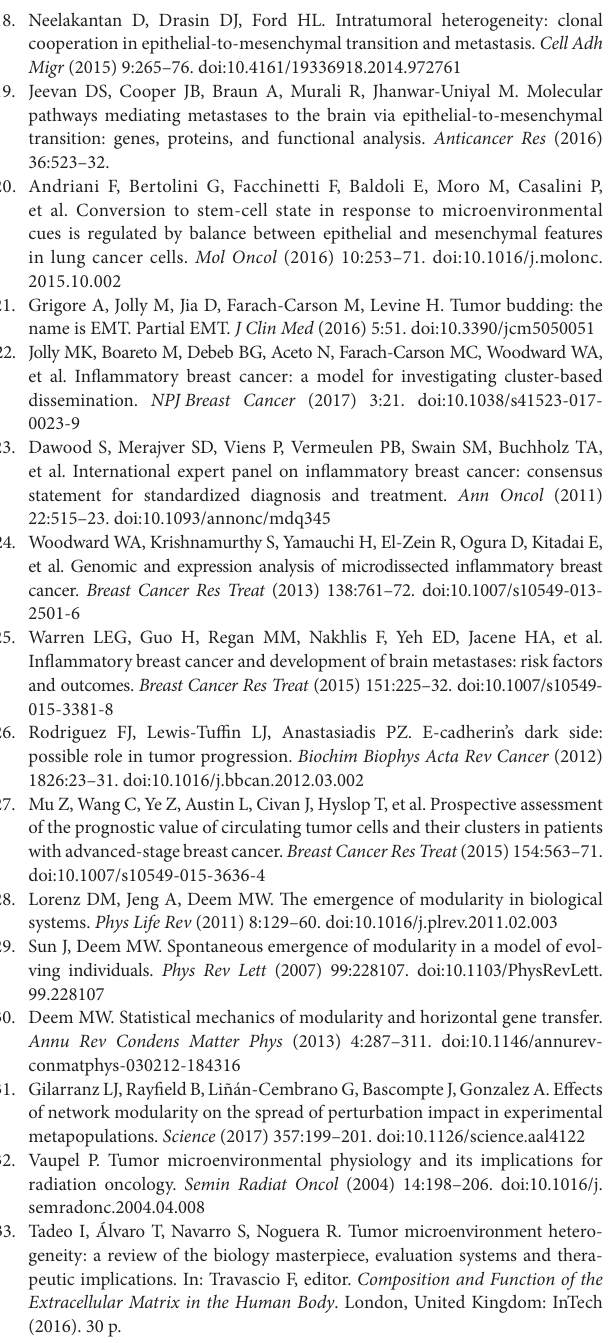
FigUre s5 | Gene set enrichment analysis on gene expression data for tumor samples from IBC and non-IBC breast cancer patients from the study by Iwamoto et al. (45) using (a) genes upregulated in cells in circulating tumor cell clusters, and (B) genes downregulated in cells in circulating tumor cell clusters. Genes are ordered from left to right in decreasing order of correlation of